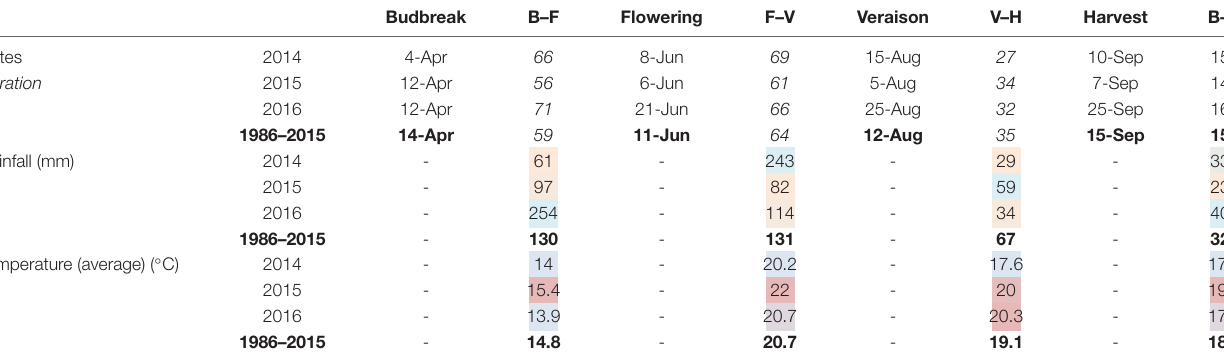
TABLE 1 | Phenological stages and phases (period during two stages) dates, durations, number of days , and corresponding cumulated rainfall and average